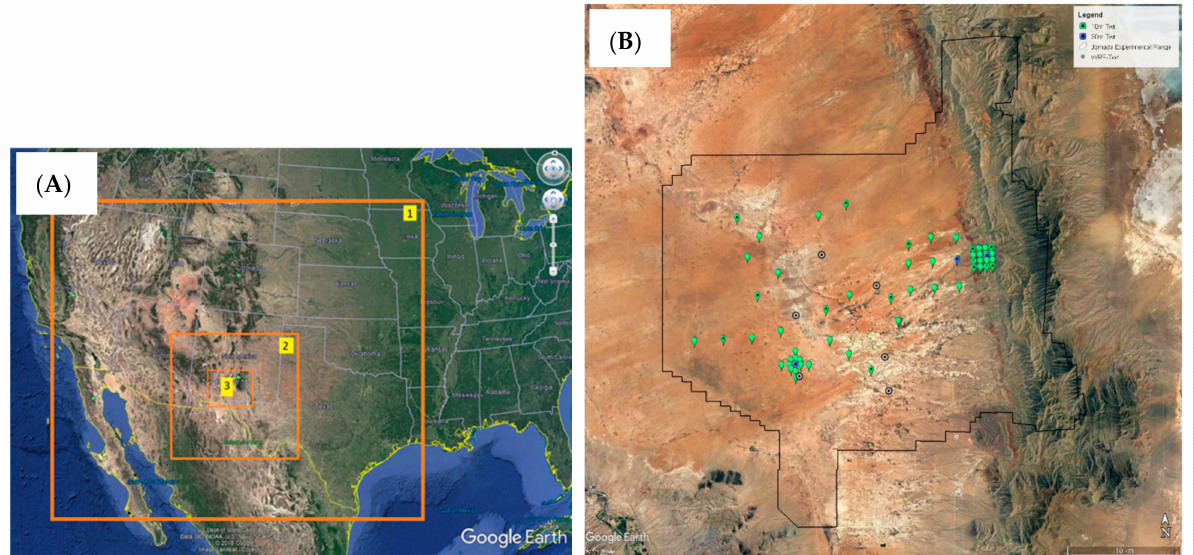
Figure 4. ( A ) Weather Research and Forecast model (WRF) domain nested grid setup. D1 = 9 km, D2 = 3 km, D3 = 1 km. ( B ) JER and MSA tower locations selected for WRF